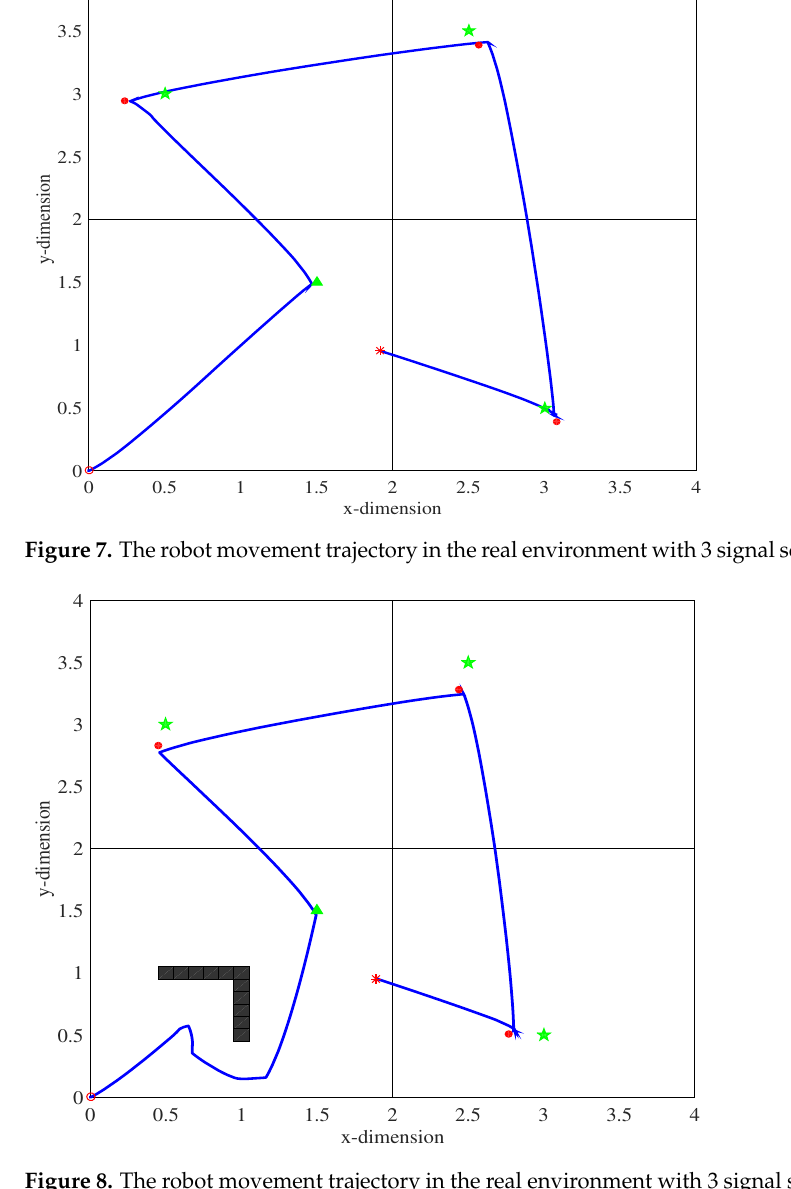
Figure 8. The robot movement trajectory in the real environment with 3 signal sources and 1 obstacle. Table 4. Average results (Standard errors) on localization time (s) and path length (m) in light of 10